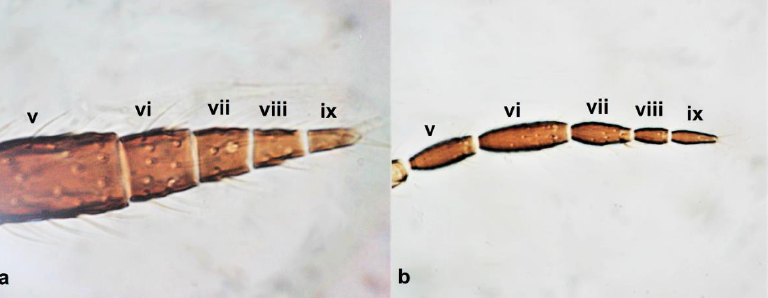
Antennal segments III and IV with sensoria set in parallel to length of segment (Figure 3a); antennal segments VI–IX broadly joined basally (Figure 4a) Aeolothripidae .. 4 Antennal segments III and IV with sensoria set perpendicular or oblique to length of segment (Figure 3b); antennal segments VI-IX constricted basally and clearly distinct Diversity 2023 , 15 , x FOR PEER REVIEW from each other (Figure 4b) .............................................................. Melanthripidae .. 12